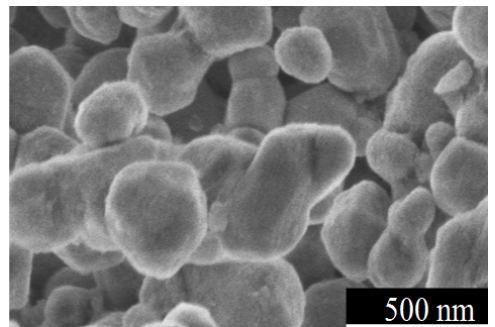
Figure 4. TEM image of titania obtained by sol-gel synthesis calcined at 400°C with particle sizes ranging from 100 to 250